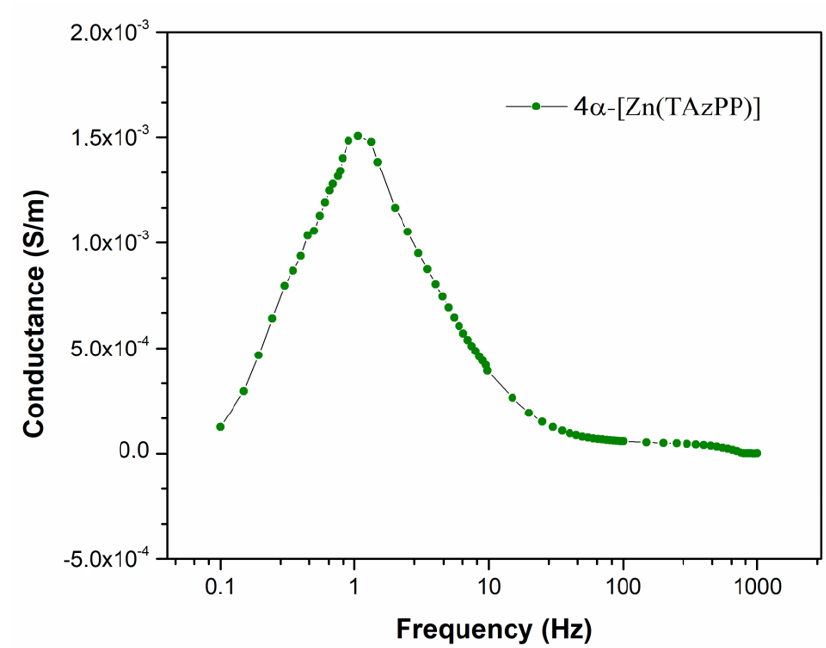
Figure 11. Conductance characteristics of complex ( 4 ).